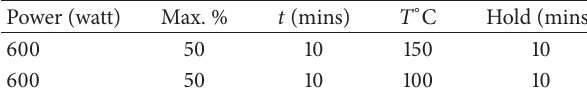
Table 2: Digestion program for smoke samples.